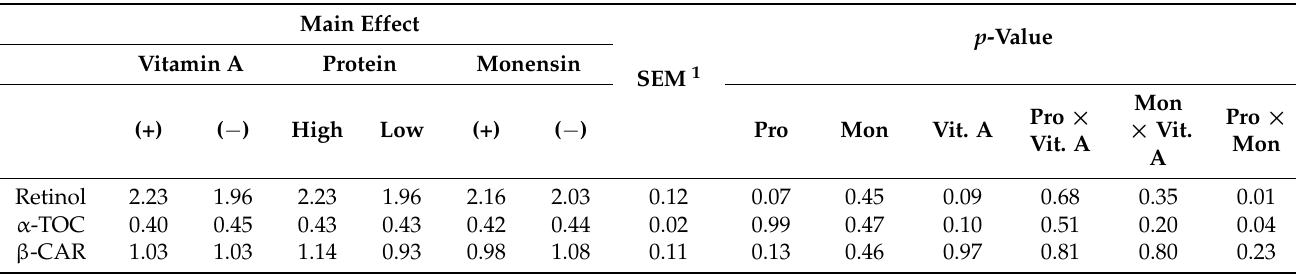
Table 4. Milk vitamin concentrations ( µ g/mL) during the first 21 days of lactation for multiparous Holstein dairy cows ( n = 80, total) that were fed diets with crude protein levels (10.3%, n = 40 vs. 12.2% dry matter basis, n = 40), and within each crude protein group that was fed monensin (400 mg/day per head or none) and vitamin A (110 IU/kg body weight or none) during prepartum period (from day − 35 to the day of calving). All cows received a common lactation ration postpartum.